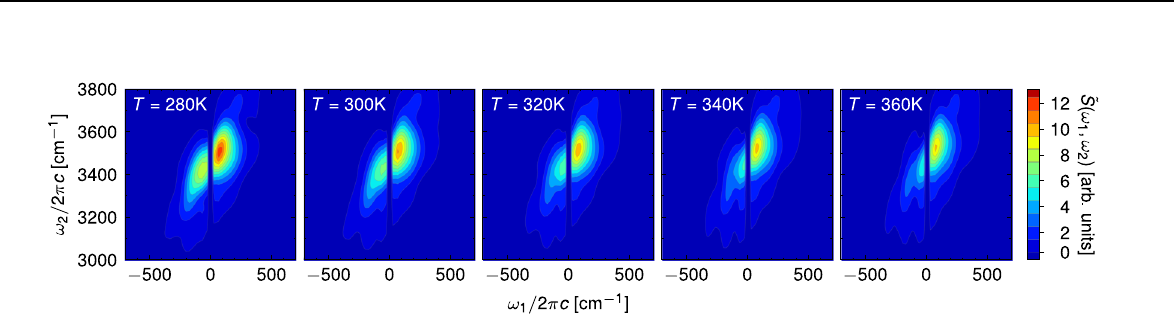
Fig.4|TemperaturedependenceoftheIIRspectrum. Two-dimensionalIIRspectraofliquidwatersimulatedwithclassicalMDatdifferenttemperatures. a TIRVpartof the spectrum. The grey squares highlight the peak around (250cm − 1 , 3600cm − 1 ). b Low-frequency part of the spectrum.